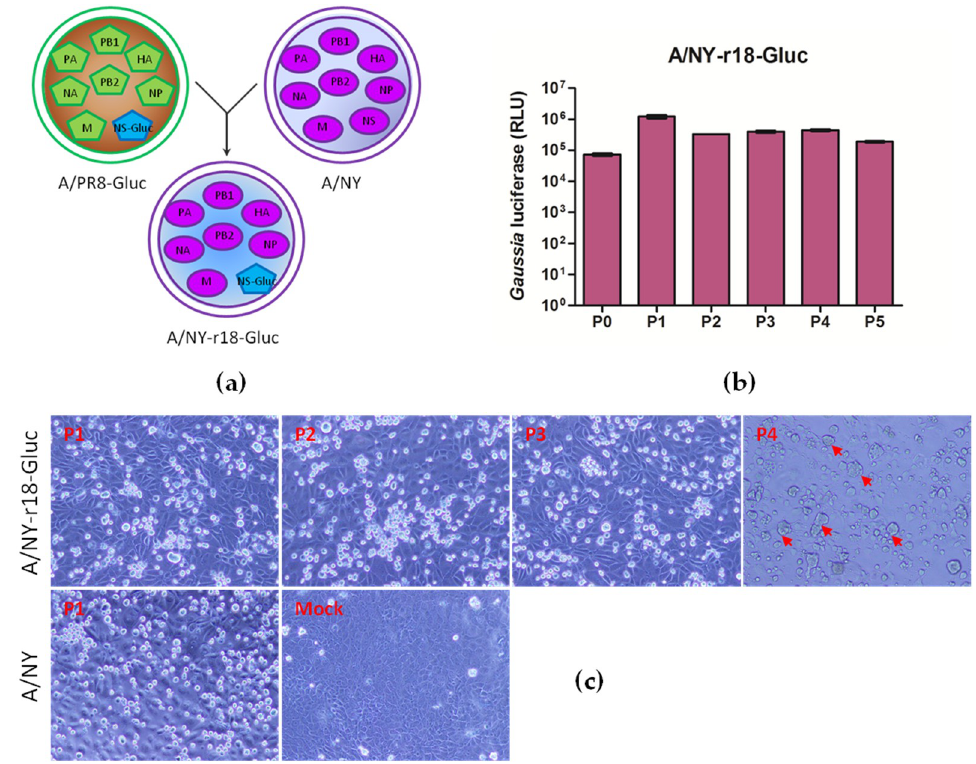
Figure 2. Generation of reporter influenza A subtype H3N2 virus by using segment PR8/NS-Gluc, which expresses NS1-Gluc chimeric protein. ( a ) Diagram of reassorment for generating reporter A/NY-r18-Gluc virus. ( b ) MDCK cells were infected with NY-r18-Gluc virus from serial passage experiments in MDCK cells (passages 0 to 5) at a MOI of 0.01. At 60 h p.i. luciferase assays were performed. ( c ) MDCK cells were mock-infected or infected with NY virus and NY-r18-Gluc virus of indicated passages respectively at a MOI of 1. Cytopathic e ff ects were observed at 60 h p.i. using Olympus inverted phase contrast microscope IX73 (magnification 200 × ). Arrows indicate the multinucleated syncytia induced by NY-r18-Gluc